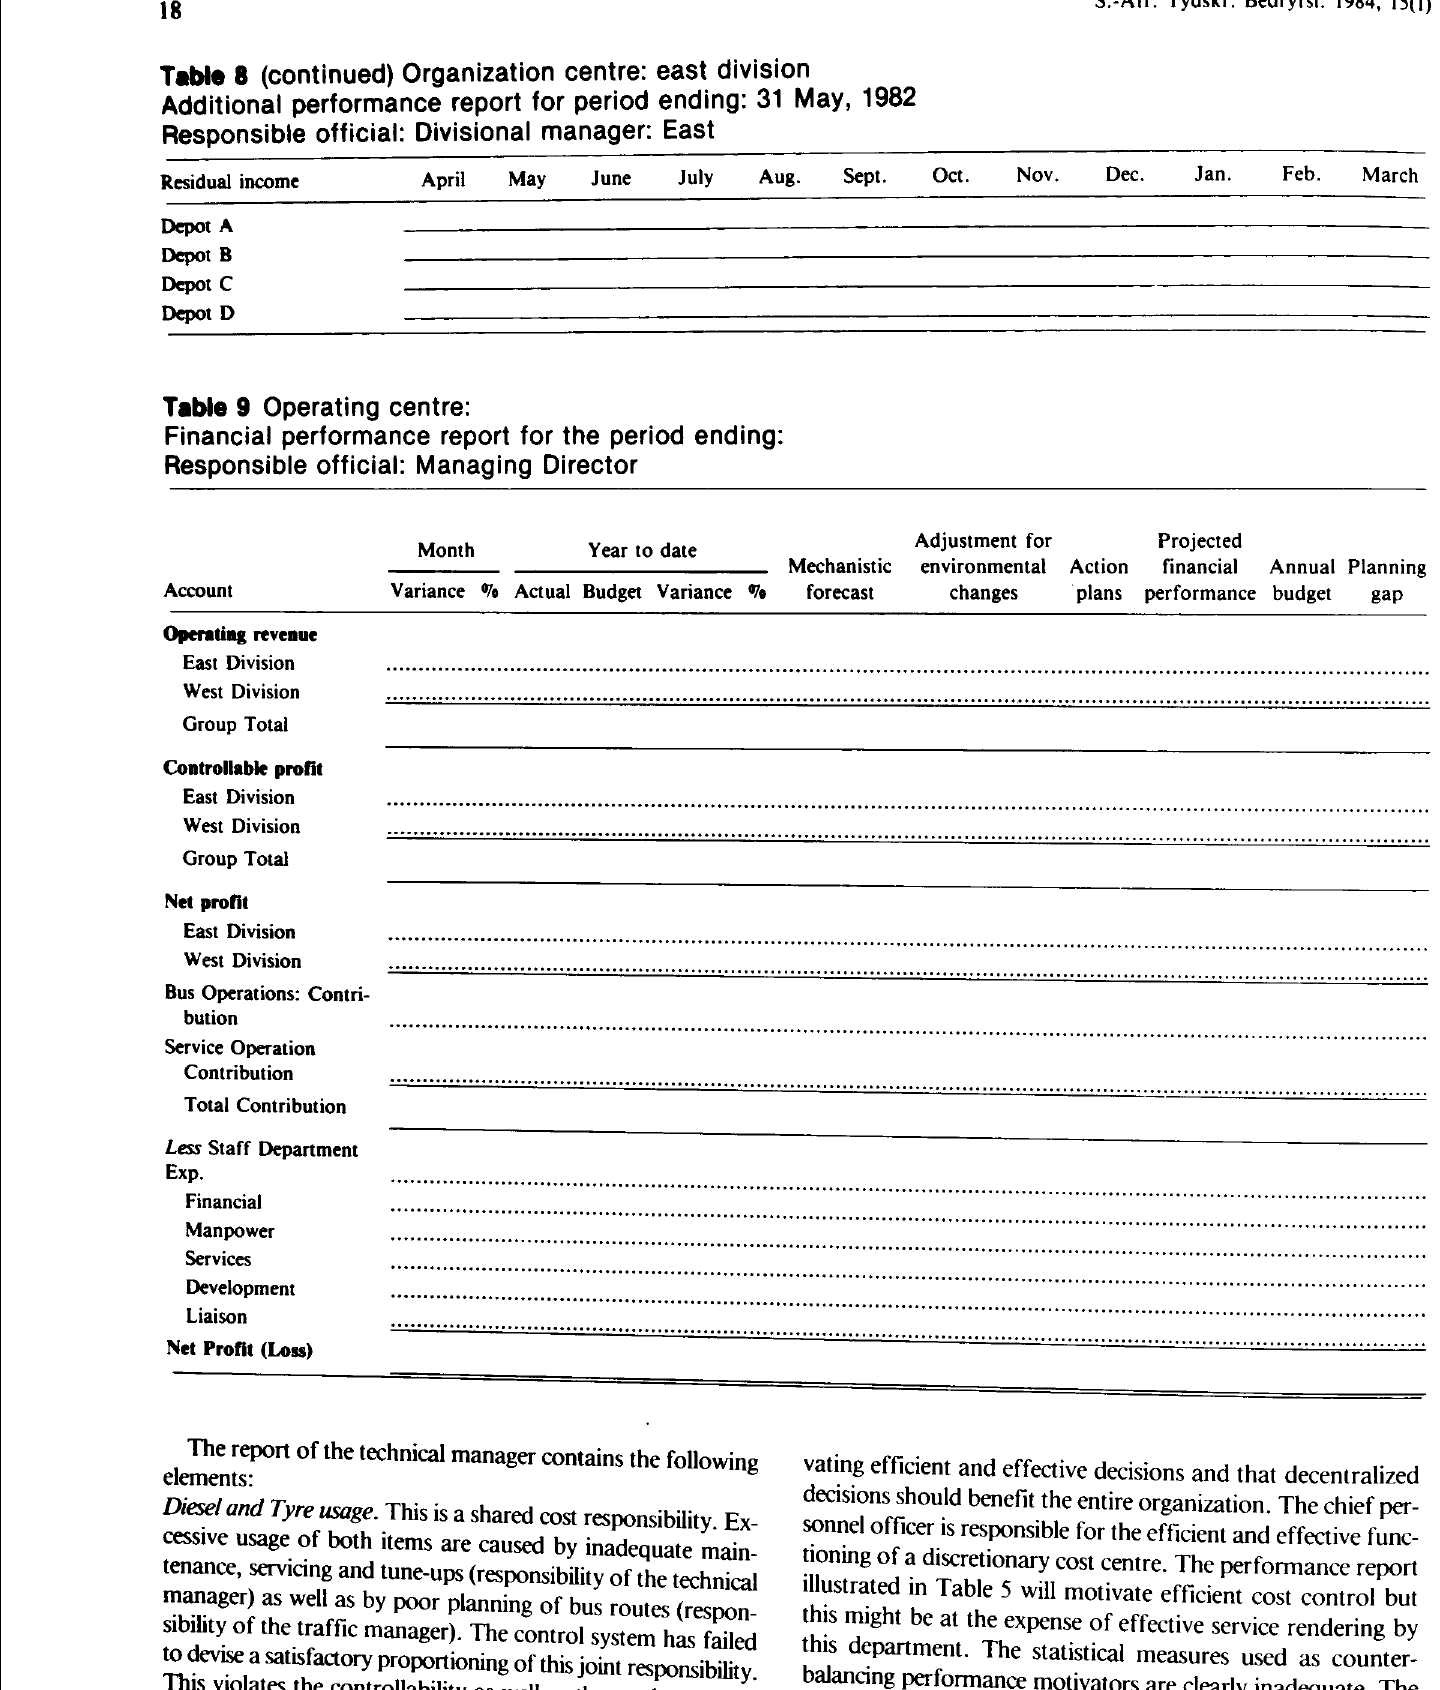
Table g Operating centre: . . . Financial performance repo~t for ~he period